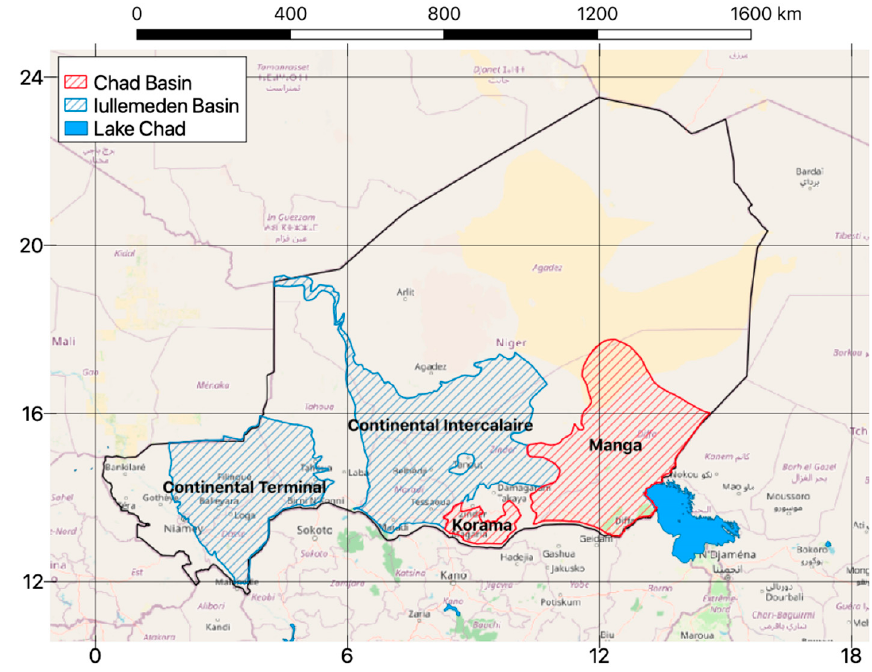
Figure 4. Selected aquifers of the Iullemeden and Chad basins (GGSA).